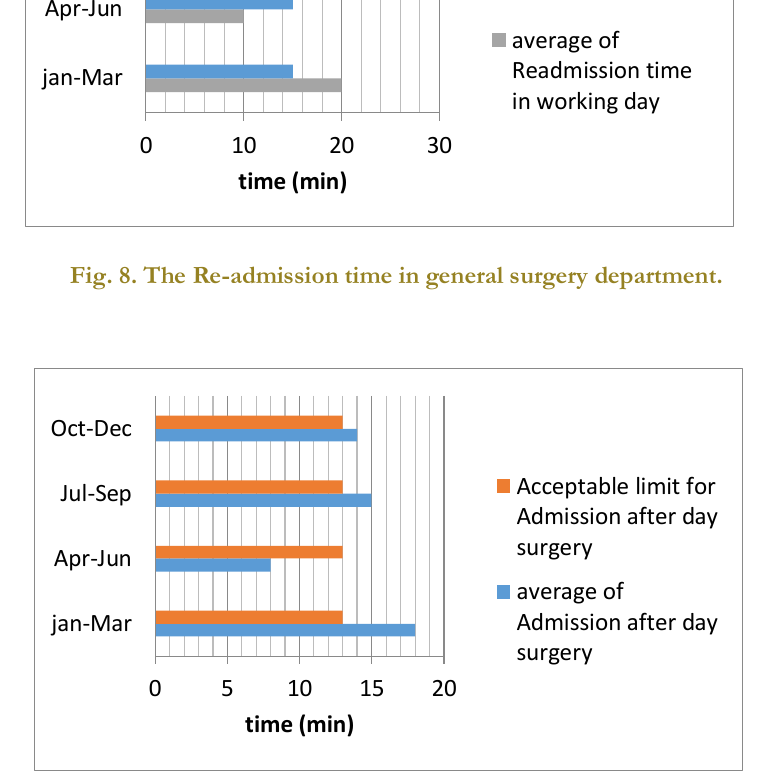
Fig. 9. The admission after day surgery in general surgery